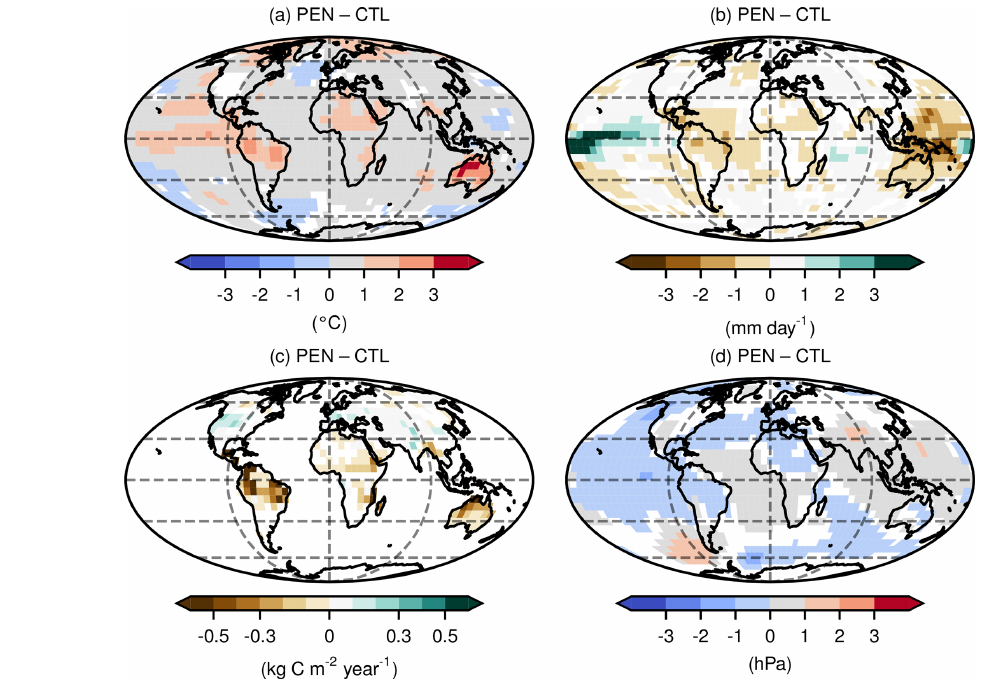
Figure 6. Differences in annual means results for the PEN simulation compared with CTL simulation (PEN minus CTL) for near-surface temperature (a) , daily precipitation (b) , GPP (c) , and mean sea level pressure (d) . In all panels, white depicts grid points with statistically non-significant difference ( α = 0 . 05). Grid lines are spaced every 30 ◦ from the Equator and 90 ◦ from Greenwich, in latitude and longitude,